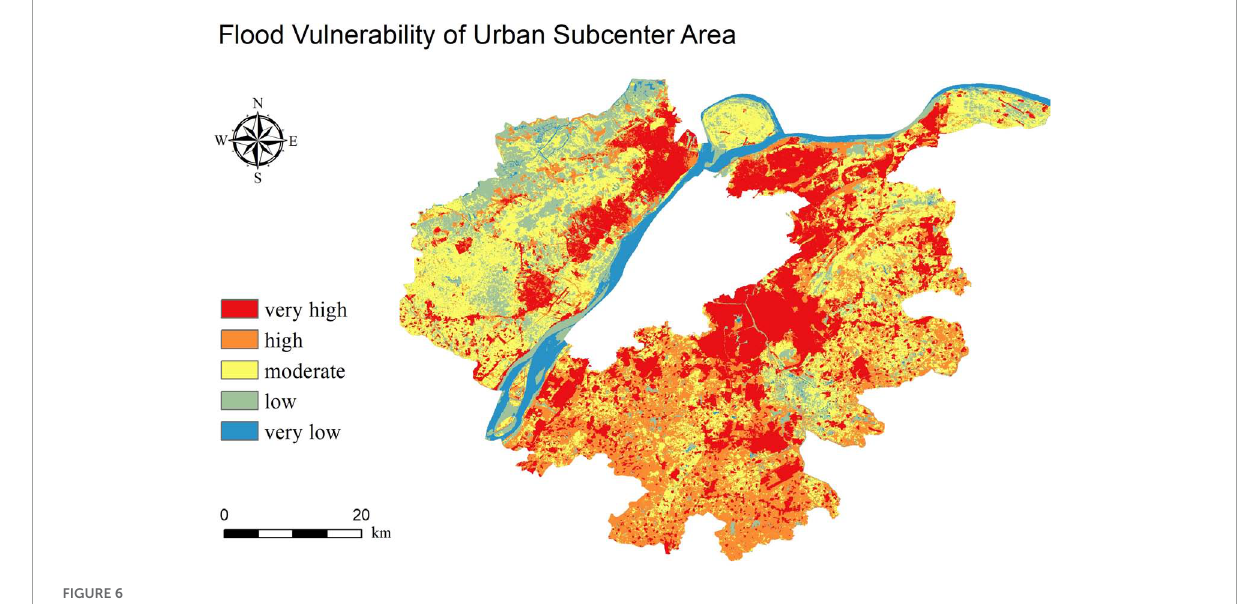
FIGURE6 The flood vulnerability levels of urban subcenter area.